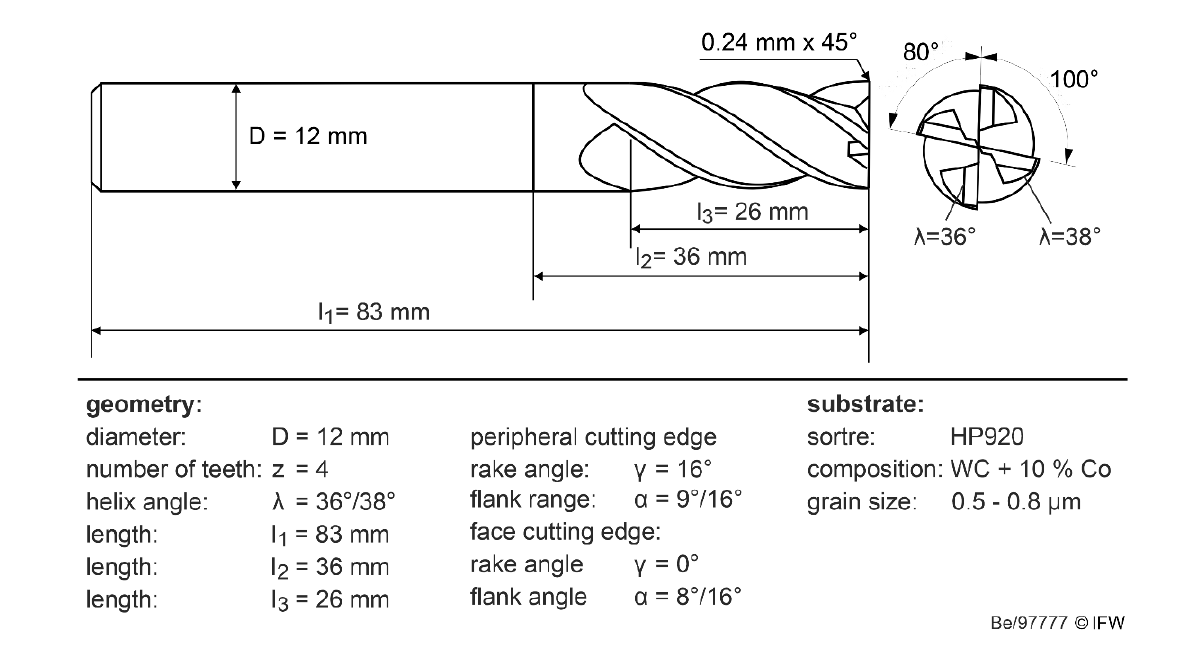
Figure 3. Resulting tool geometry after grinding. Table 1. Process Parameter during the grinding of end